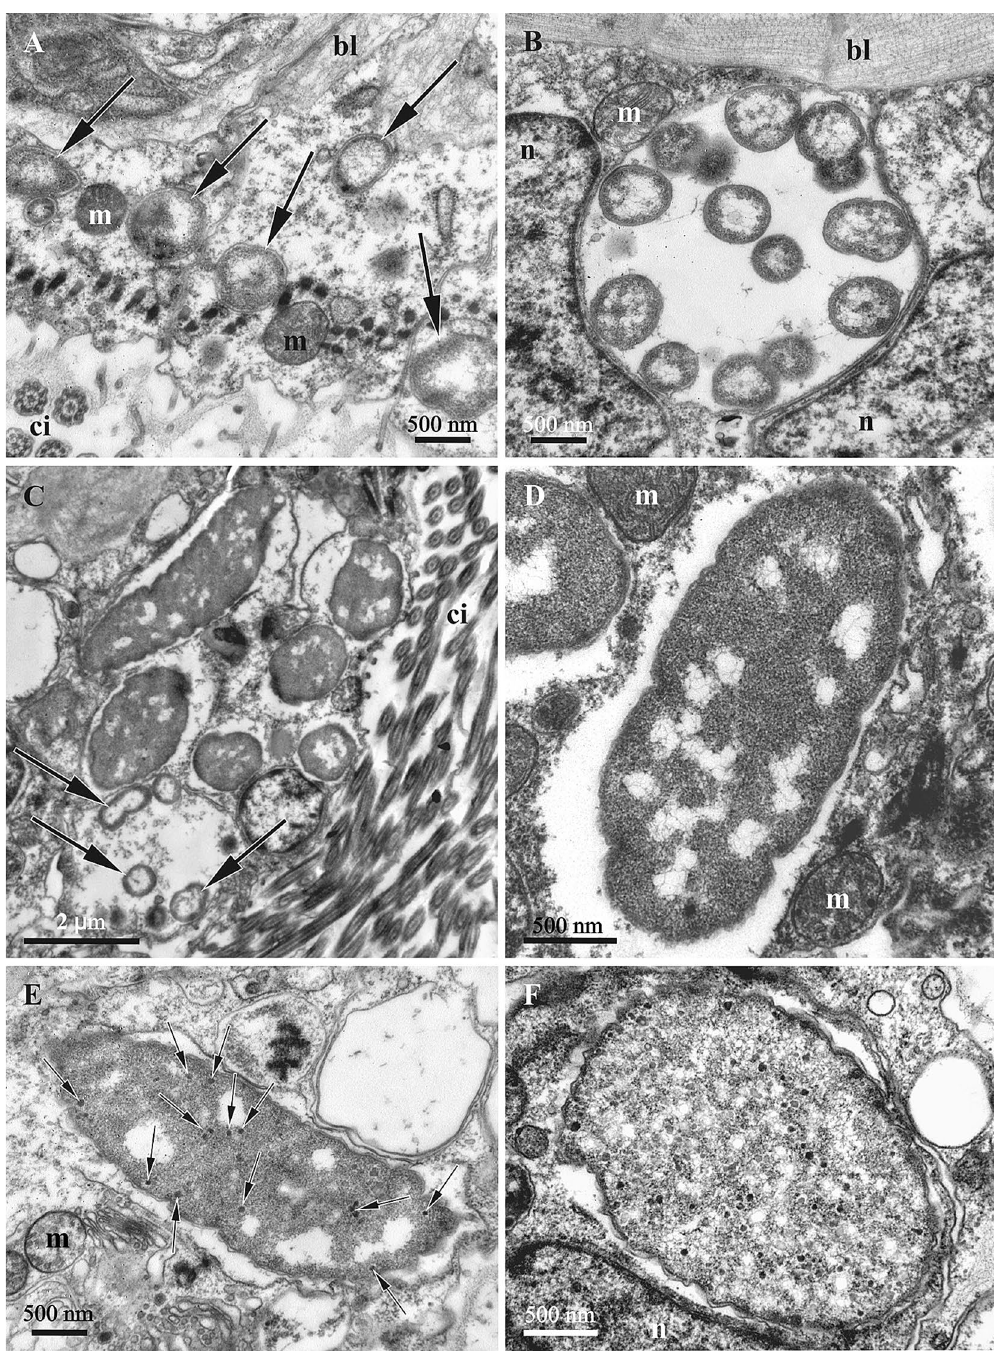
Figure 5. Symbiotic bacteria inside tentacles of Bugula neritina . TEM. ( A , B ) coccoid symbiotic bacteria of ‘type I’ inside the cytoplasm ( A , arrows) and a large vacuole ( B ) in the ciliated cells of the tentacles (sectioned kinetosomes and cilia are visible in the lower half of the image ( A ). ( C ) groups of smaller coccoid bacteria of ‘type I’ (arrows) and the larger rod-like bacteria of ‘type II’. ( D , E ), ‘type II’ bacterial cells without ( D ) and with ( E ) few electron-dense virus-like particles (little arrows). ( F ) symbiotic bacteria of ‘type III’ inside with viral particles in their cytoplasm. TEM. Abbreviations: bl, basal lamina; ci, cilia; m, mitochondria; n,